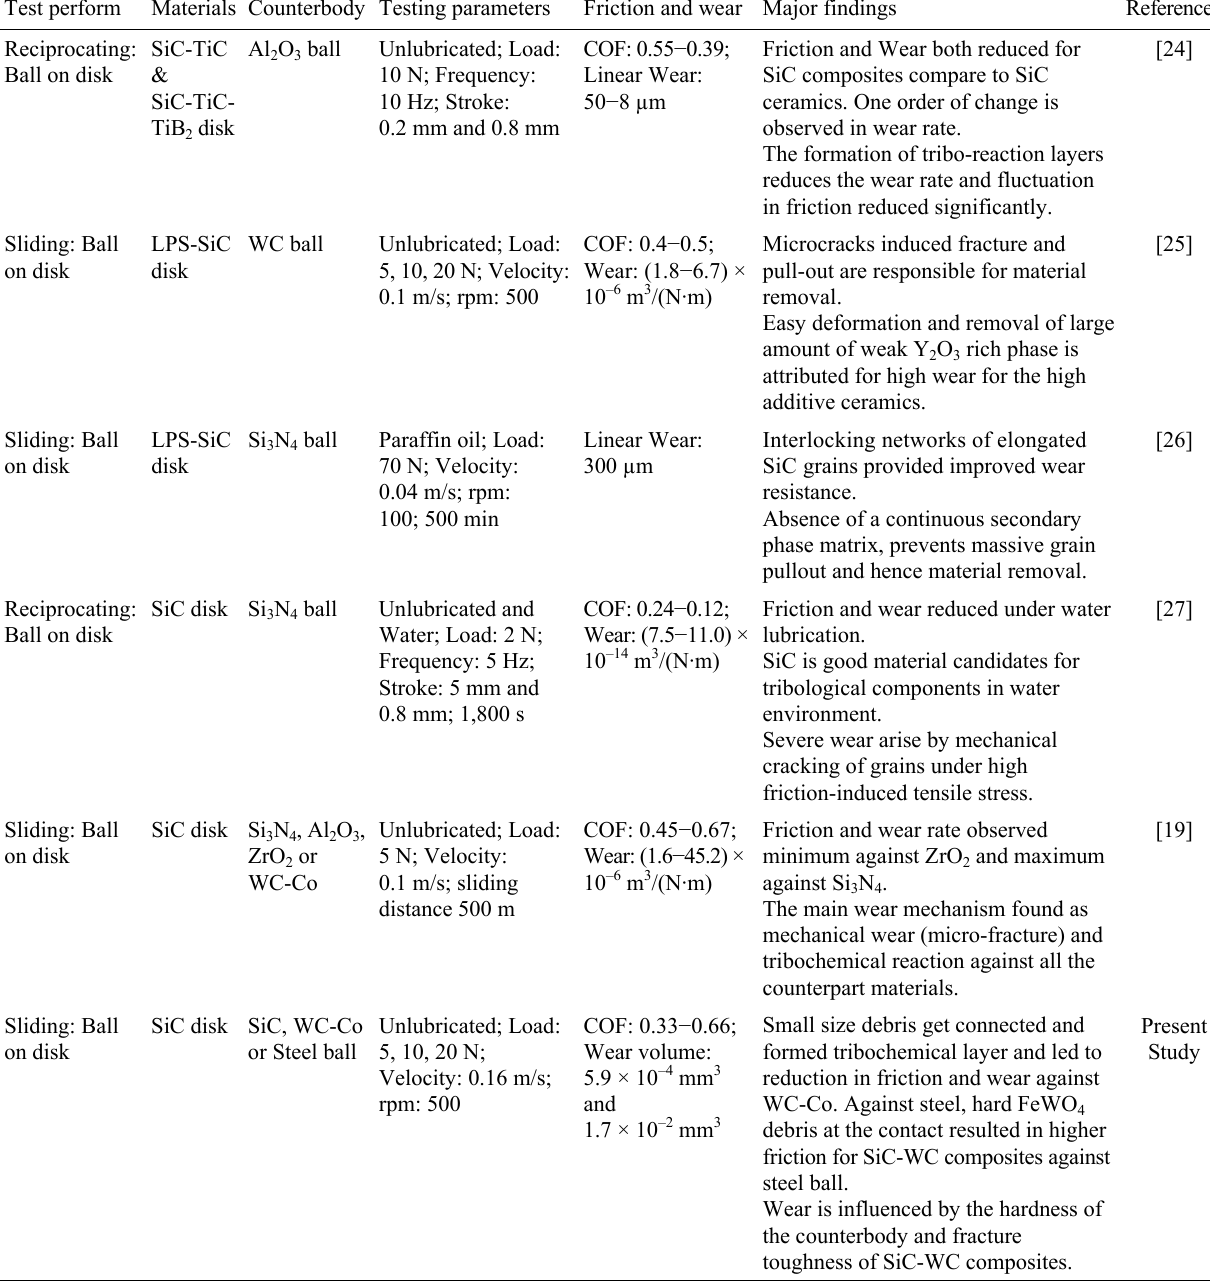
Friction and wear rate observed minimum against ZrO 2 and maximum against Si 3 N 4 . The main wear mechanism found as mechanical wear (micro-fracture) and tribochemical reaction against all the counterpart materials. formed tribochemical layer and led to reduction in friction and wear against debris at the contact resulted in higher friction for SiC-WC composites against steel ball. Wear is influenced by the hardness of the counterbody and fracture toughness of SiC-WC